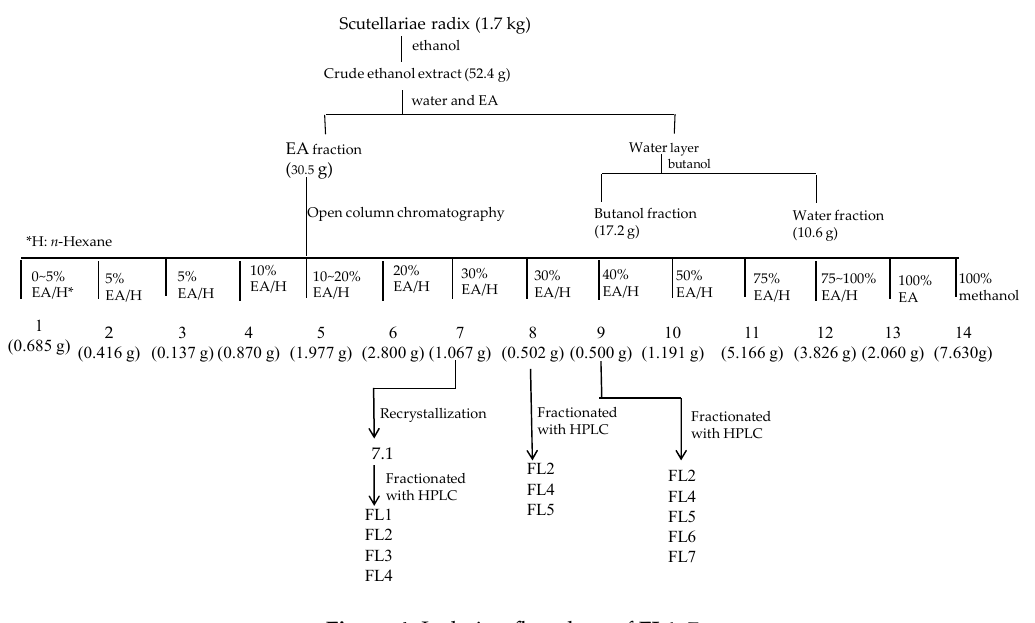
Figure 5. Retention time and purity analysis of FL1 – 7 in HPLC.